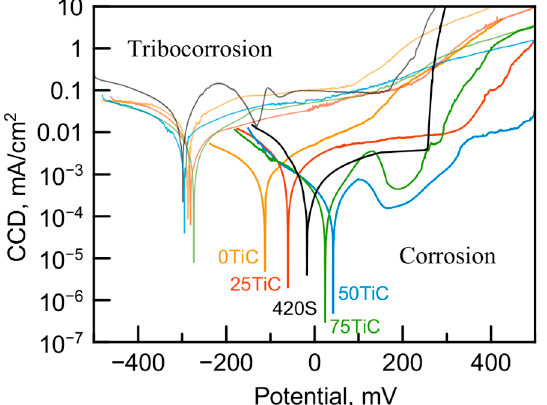
Figure 9. Potentiodynamic curves of coatings and steel substrate recorded during experiments in steady-state (corrosion) and under wear conditions (tribocorrosion).